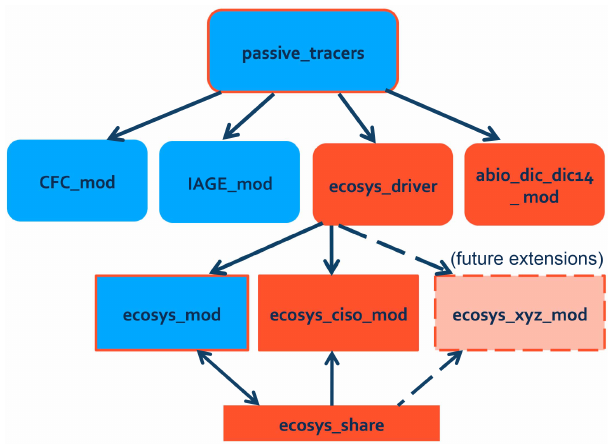
Figure 1. Schematic of the passive tracer modules with the new ecosystem driver and carbon isotope modules. Existing modules are shown in blue, new modules are shown in red, and edited mod- ules are shown in blue with a red box. Dashed lines indicate fu- ture developments. This schematic shows how the ecosystem driver acts as an interface between the ecosystem-related modules and the passive tracers module that drives all tracer modules as well as how ecosys_share is used to share variables computed by the ecosystem model and used by other modules beside the ecosystem